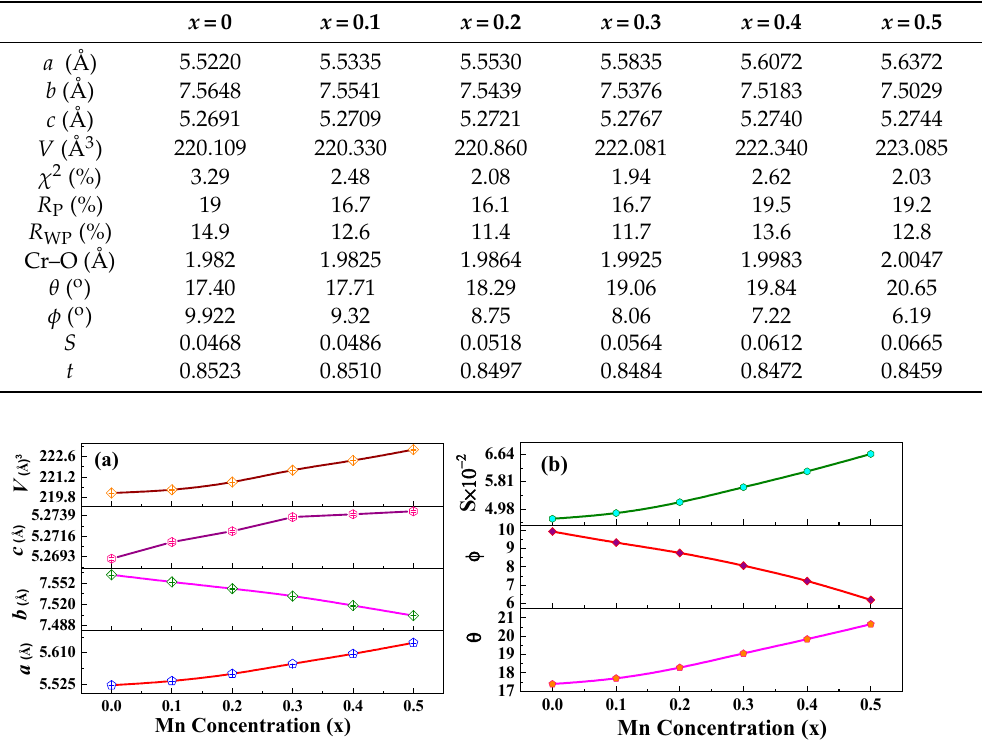
Figure 2. ( a ) Lattice parameters, volume, ( b ) strain parameter and tilt angle variation as a function of Mn concentration.